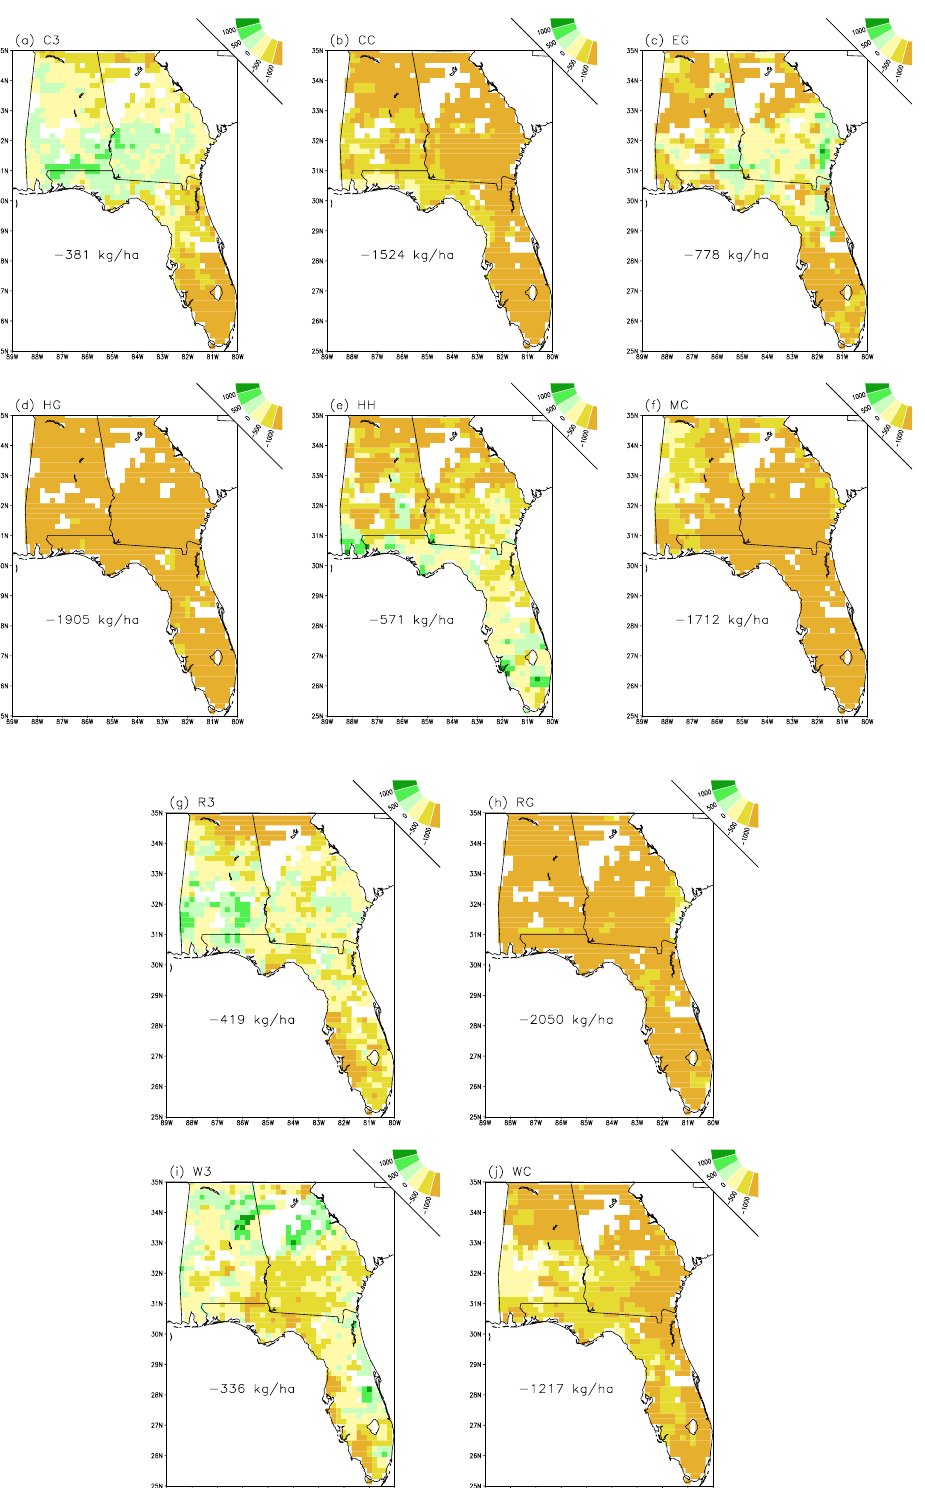
Figure 3. Ten simulated NARCCAP regional-model-driven maize dry matter yield differences between future (2041–2070) and current (1971–2000) runs under rainfed conditions. Unit is of kg ha − 1 . Area-averaged values are shown.